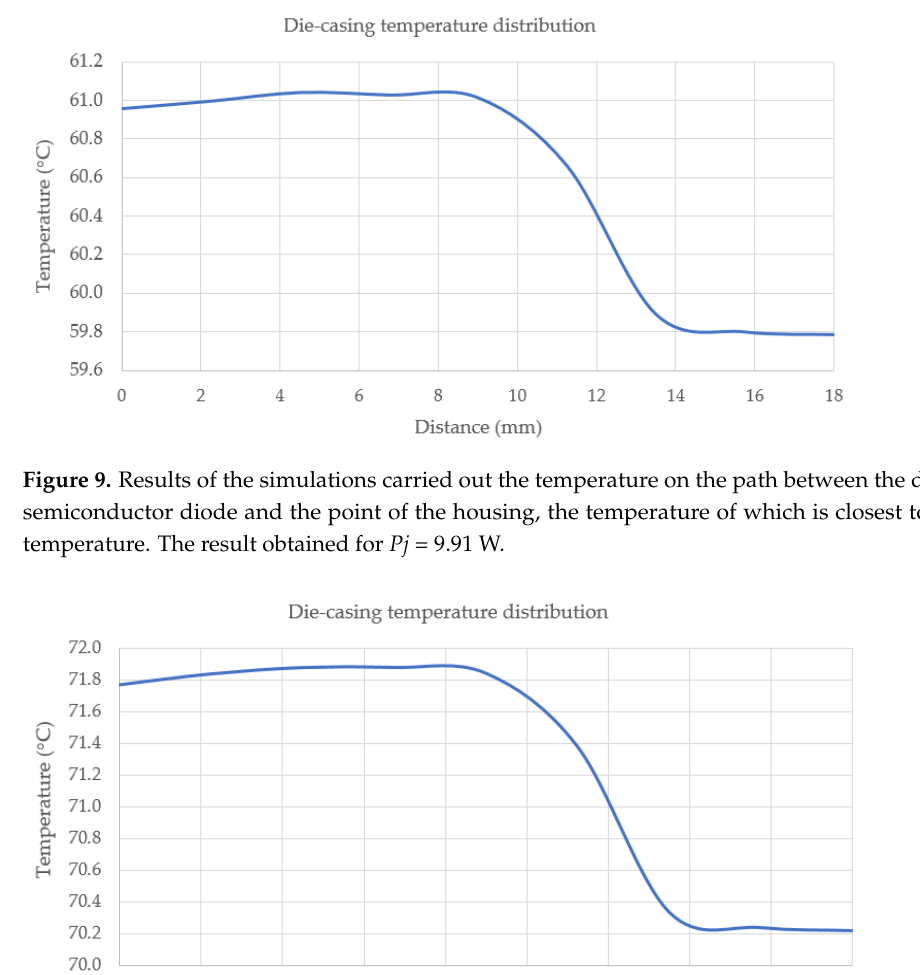
Figure 8. Results of the simulations carried out the temperature on the path between the die of the semiconductor diode and the point of the housing, the temperature of which is closest to the die temperature. The result obtained for Pj = 8.17 W.